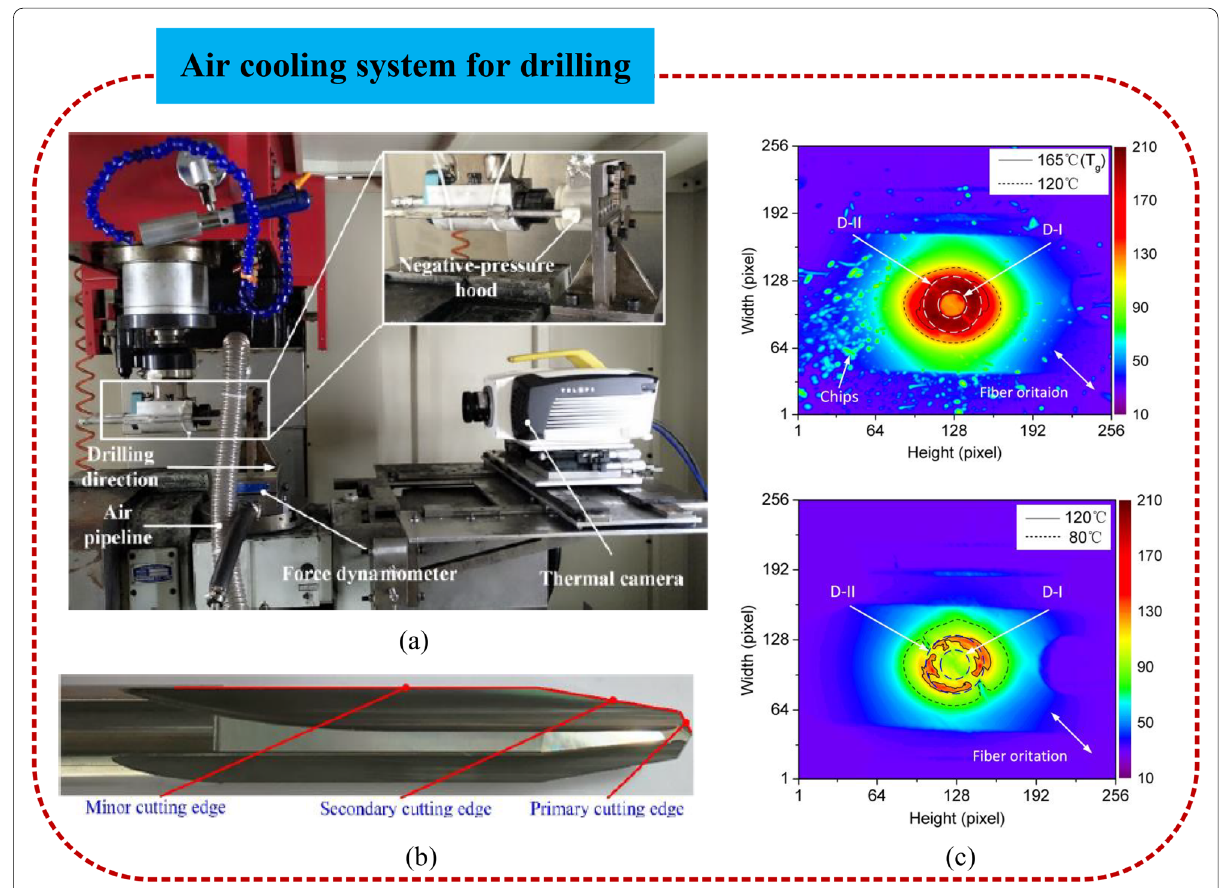
Figure 32 Air cooling system for drilling: a Experimental layout of drilling system, b Double point angle drill bit, c Distribution map of maximum temperatures at drill exit